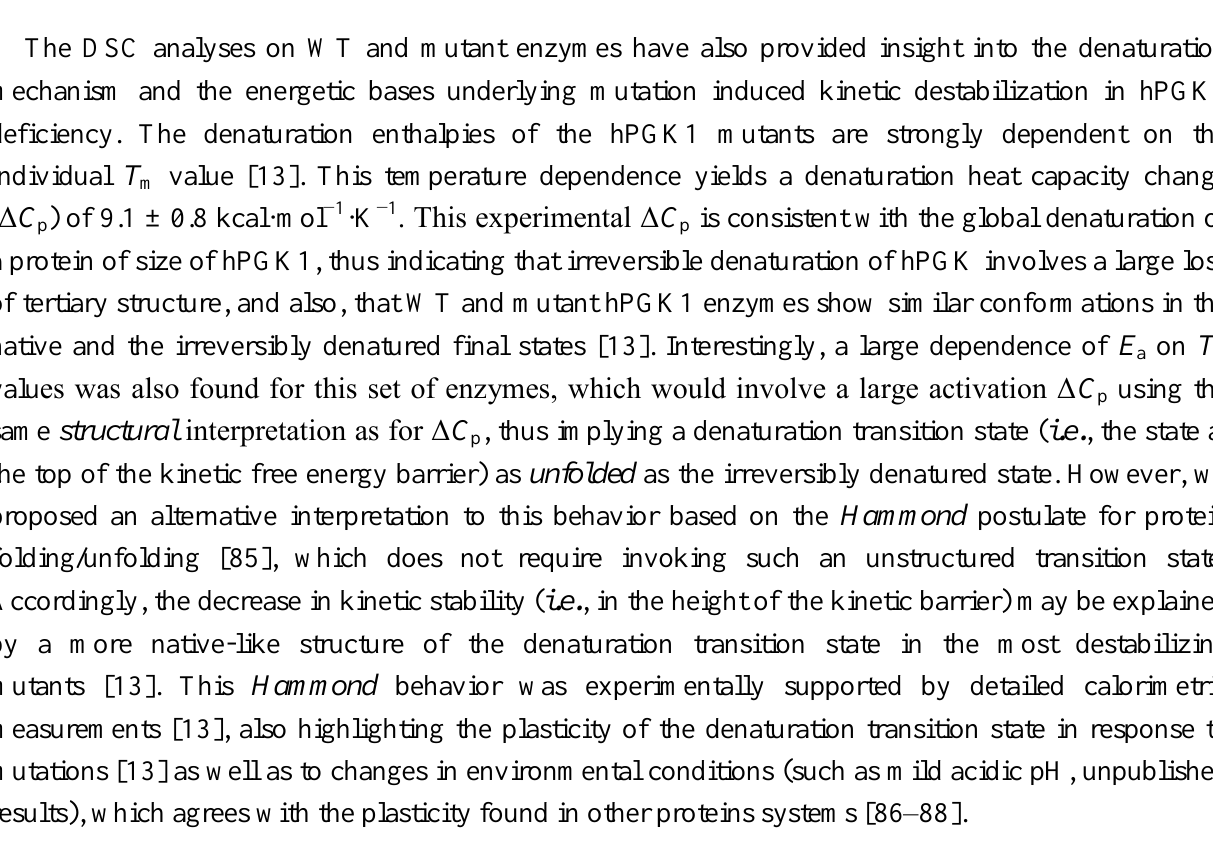
Table 2. Parameters describing thermodynamic and kinetic stabilities of human PGK1 WT and p.T378P enzymes. Data from